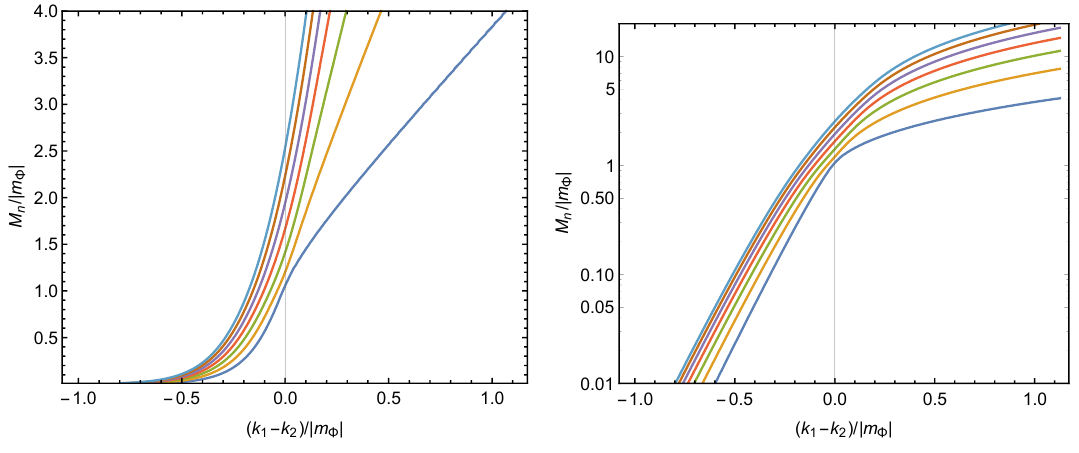
Figure 1 . KK masses ( n = 1 ; 2 ; (cid:1) (cid:1) (cid:1) ; 7) as a function of (cid:20)= j m (cid:8) j (cid:17) ( k 1 (cid:0) k 2 ) = j m (cid:8) j for (cid:12)xed values of m (cid:8) and R (left: linear, right: log). For graviton ( j m (cid:8) j = k 1 + k 2 = 2), the RS limit corresponds to ( k 1 (cid:0) k 2 ) = j m (cid:8) j = 1, while the LED limit is ( k 1 (cid:0) k 2 ) = j m (cid:8) j = (cid:0) 2.